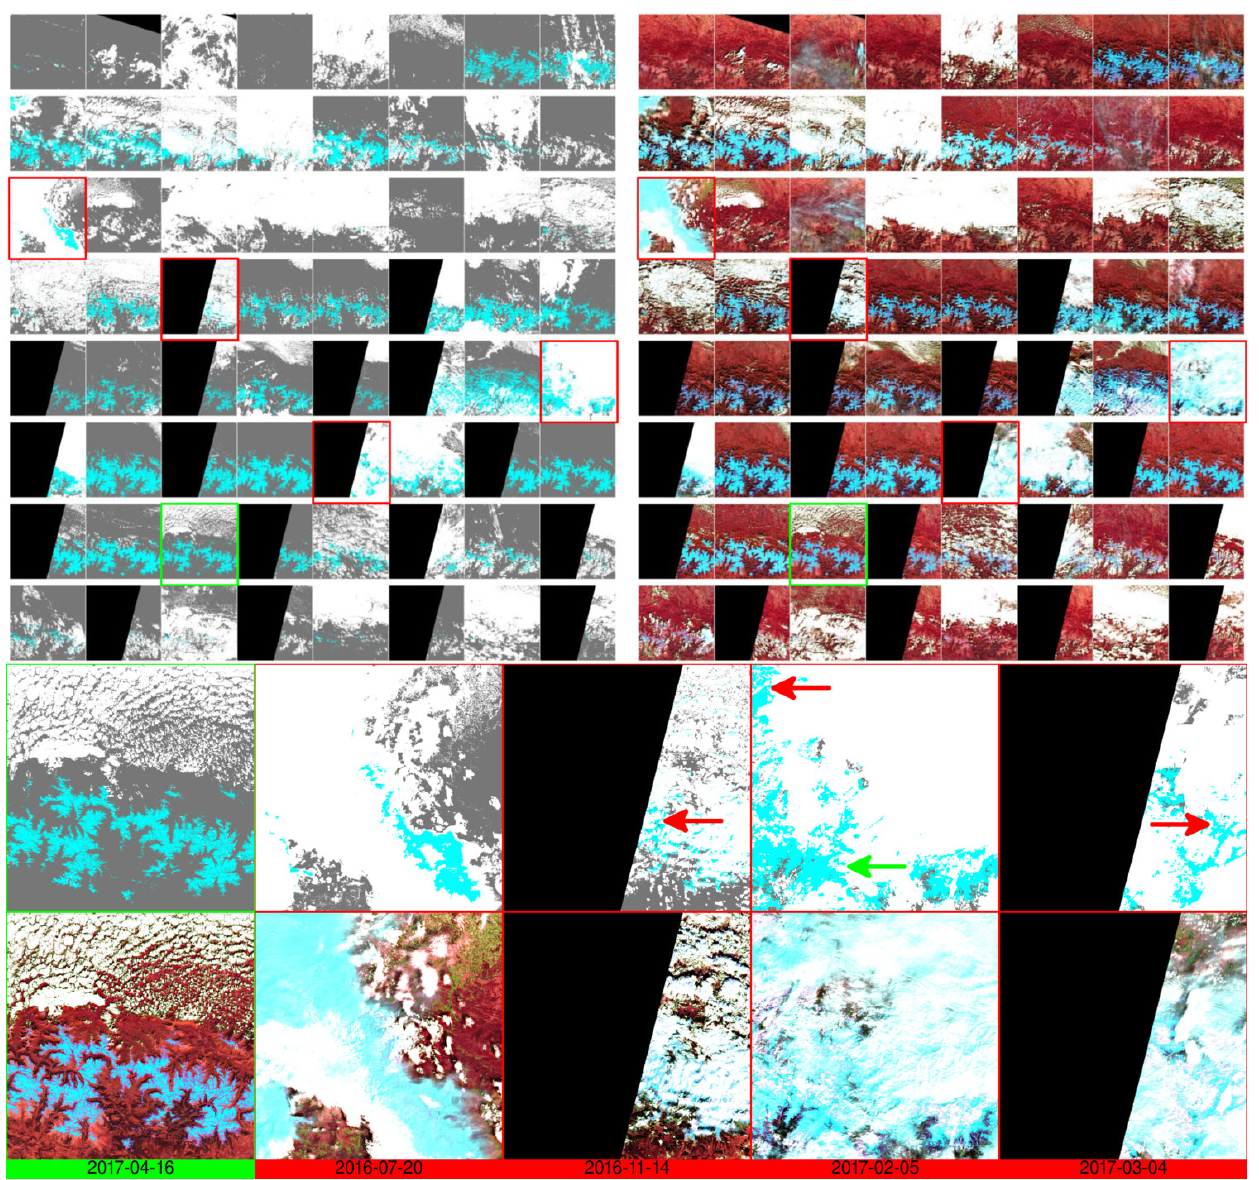
Figure 11. Full time series of Theia snow products from 6 July 2015 to 2 July 2017 over tile 31TCH. Four products with visually evident false snow detections are framed in red and shown at higher resolution. Red arrows indicate the location of the false snow patches, while the green arrow indicates a true snow patch. The product of 16 April 2017 is shown as a reference to help the visualization of the